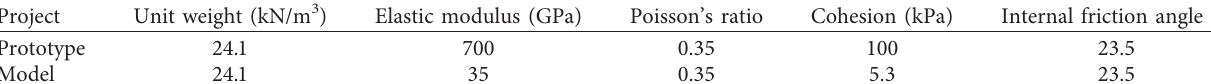
Figure 4: Model test box. Table 2: Theoretical value of mechanical parameters of similar materials for the surrounding rock.